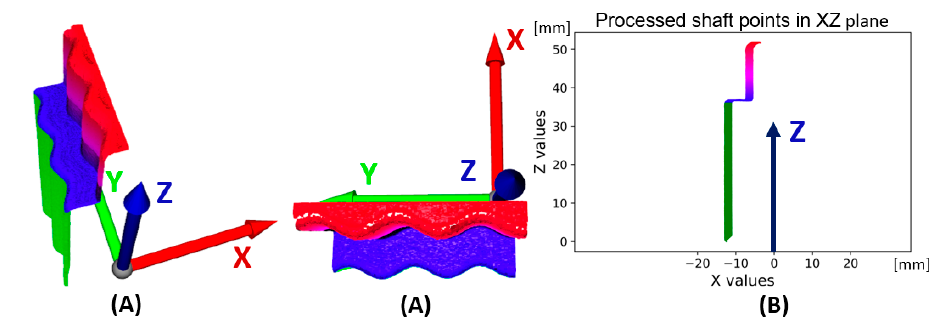
Figure 7. Data visualization of processed shaft surfaces scan, measuring 1, file “k1.csv” ( A )—3D (green surface—Base shaft surface), ( B ) scanned surfaces projected to 2D—plane XZ (green line— Base shaft surface).